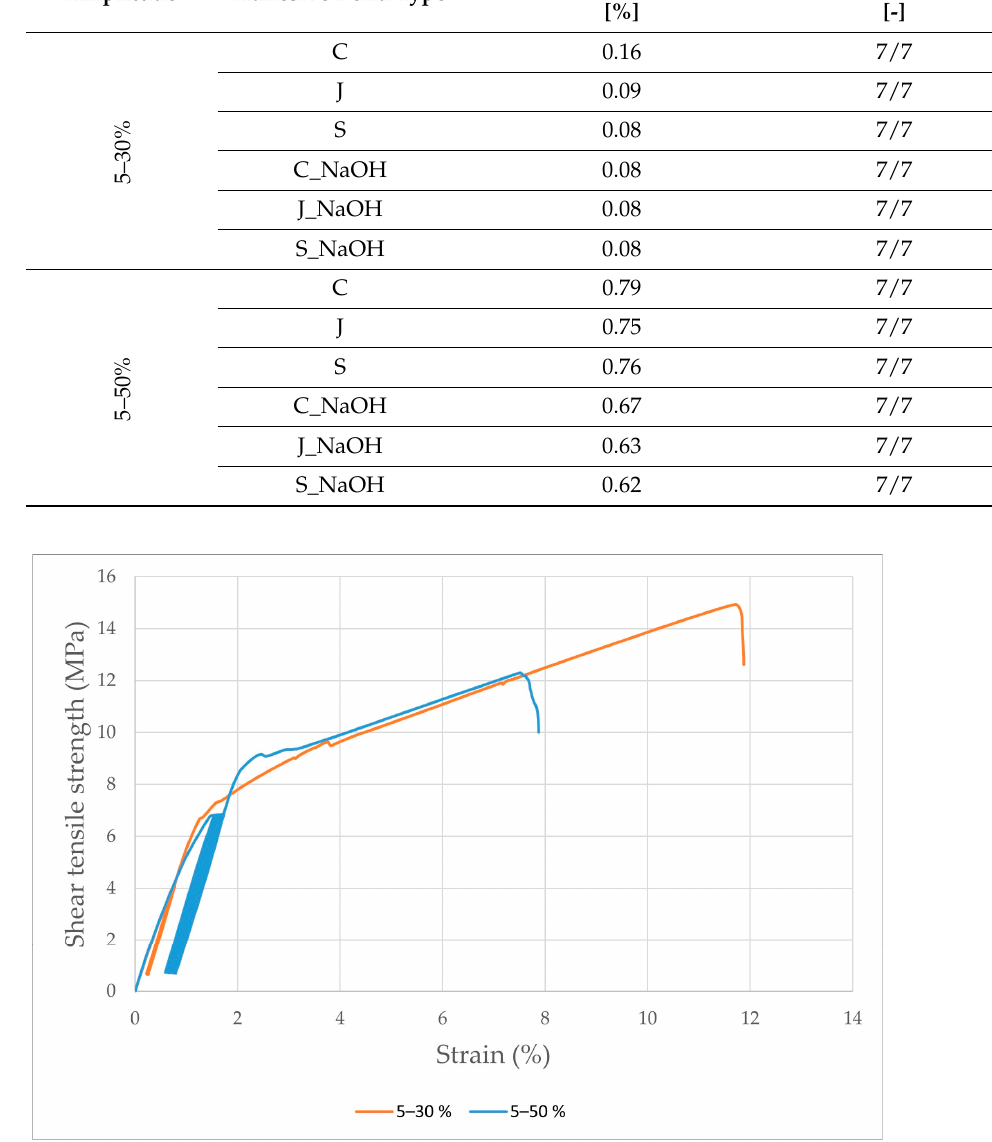
Figure 10. Quasi-static curves of the J_NaOH adhesive bond at a cyclic loading amplitude of 5–30% and 5–50%.